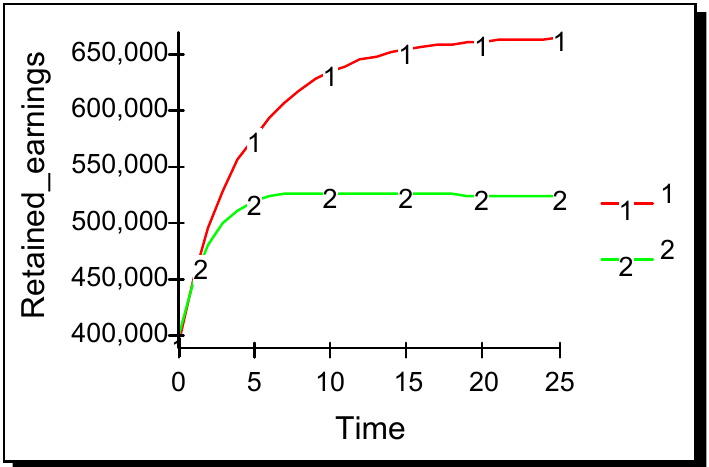
Figure 8. Asymmetric advertising, below threshold. Advertising effectiveness: φ 1 = 0.000010; φ 2 = 0.000009. ϕ 2 =